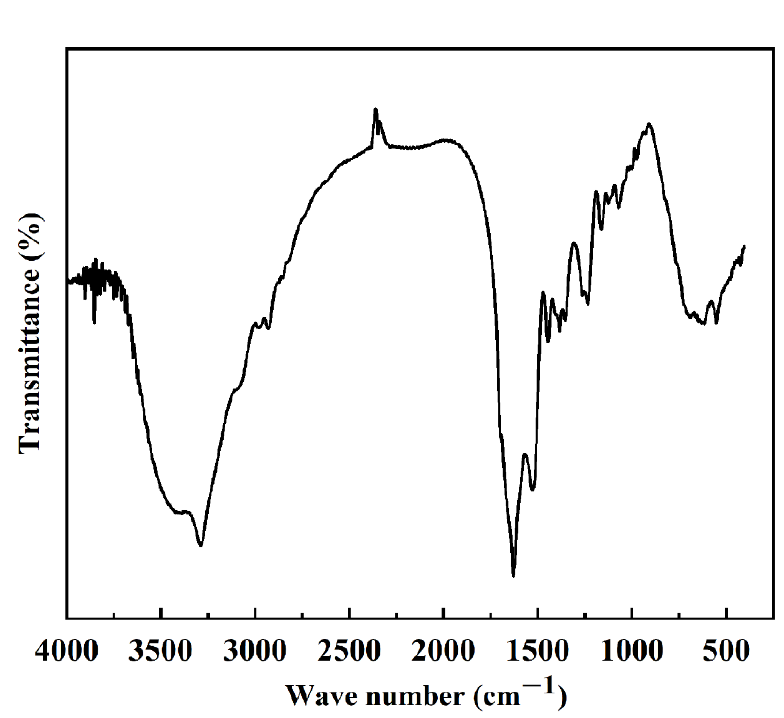
Figure 2. Infrared absorbance spectrum of silk fibroin. Table 1. Infrared characteristic peaks and secondary structure relationship table.